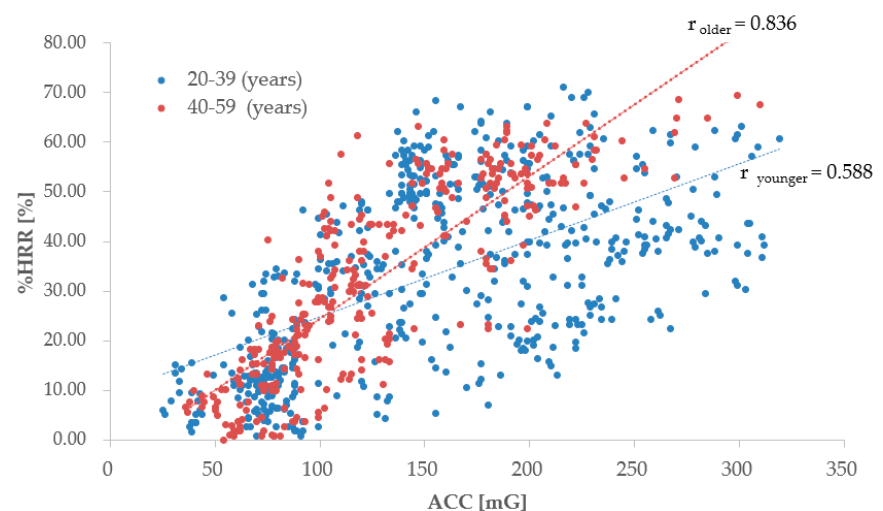
Figure 3. Relationship between ACC and %HRR (workers’ age level are 20–39 years-old and 40–59 years-old. r 20–39 and r 40–59 are the correlation coefficients of the relationship between ACC and %HRR for 20–39 years-old and 40–59 years-old, respectively.